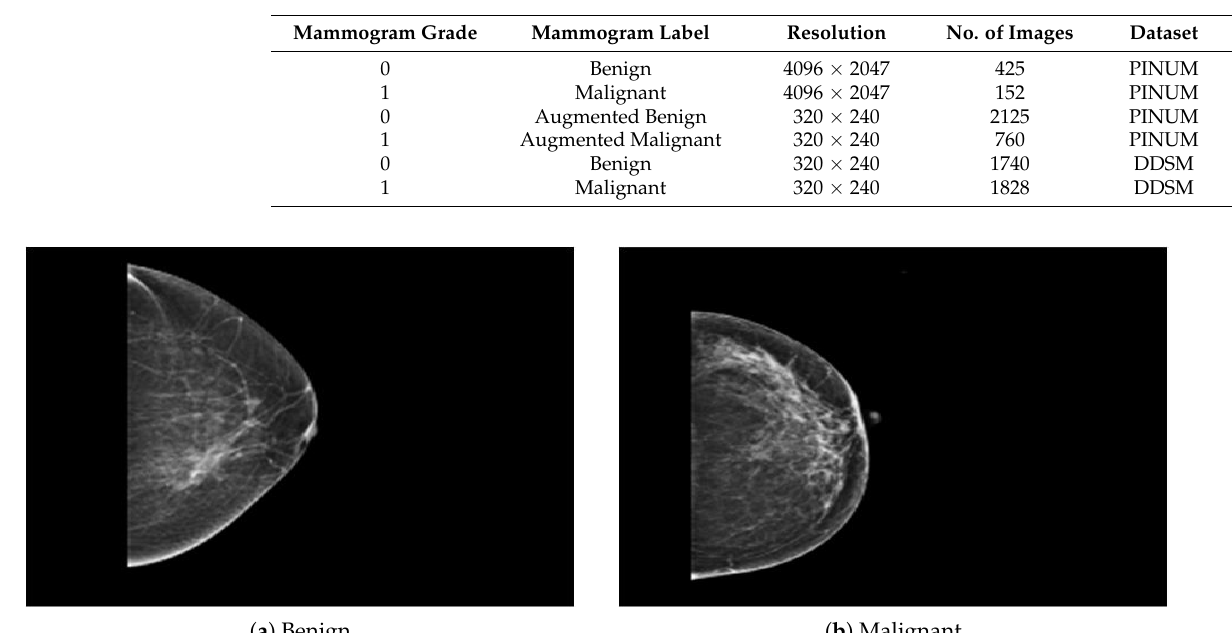
Table 1. Dataset description and detail.